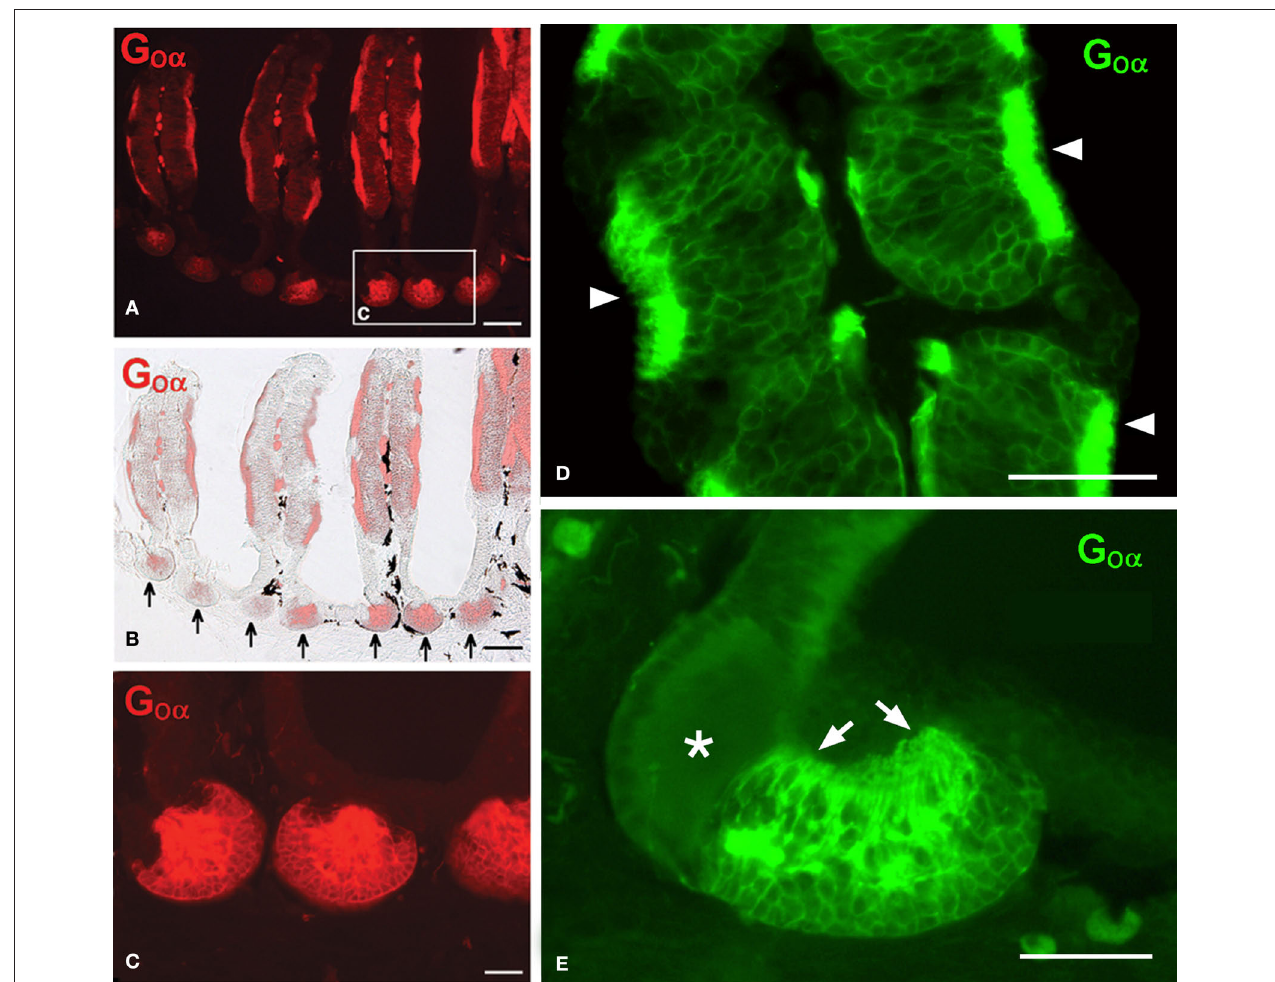
Figure 2 | The olfactory epithelium in the lamellae and the crypts contains cells immunoreactive for go α . ( A,B) Fluorescence microscopy (A) and Go α immunoreactivity combined with light microscopy (B) showing Go α immunoreactivity in the olfactory epithelium and in the epithelial crypts at the base of the lamellae (arrows). (C) Higher magnification of the area indicated in a.